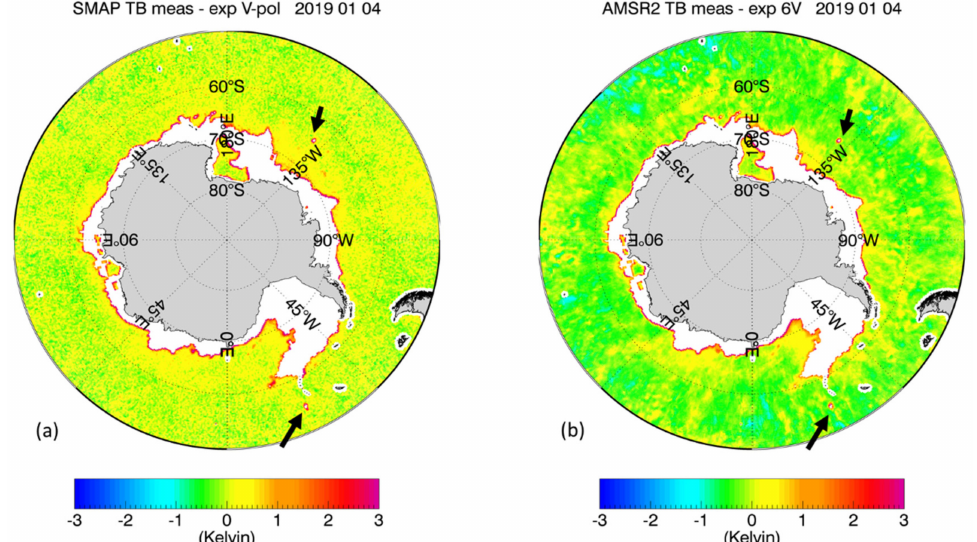
Figure 2. 8-day average TB biases near the Antarctic sea-ice edge for a scene during the Austral summer (4 January 2019) ( a ) SMAP V-pol; ( b ) AMSR2 6.93 GHz V-pol channel. The TB bias is defined as the difference between measured and expected (computed) specular surface TB. The sea-ice contamination results in a positive TB bias for both SMAP and AMSR2 near the ice edge, which results in a fresh (negative) bias in the retrieved SSS. The black arrows indicate possible candidates of very large floating icebergs (Section